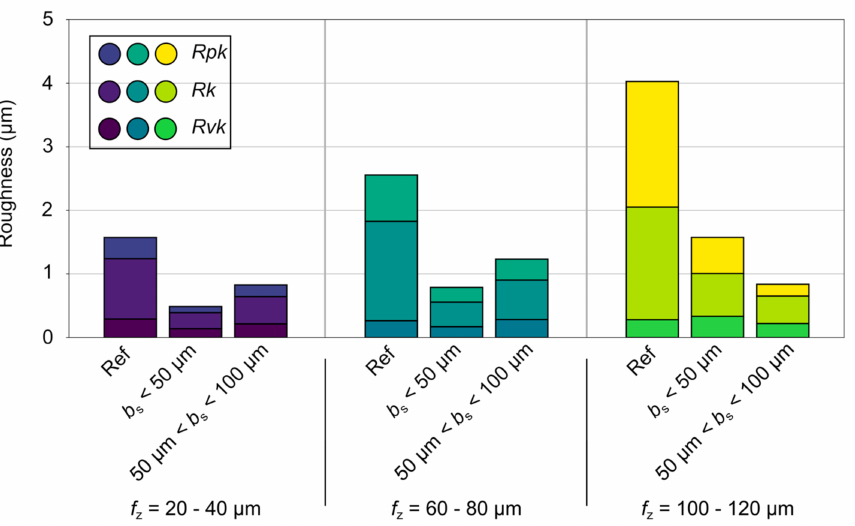
Figure 12. Surface characteristics with the parameters core roughness depth ( Rk ), reduced peak height ( Rpk ), and reduced valley depth ( Rvk